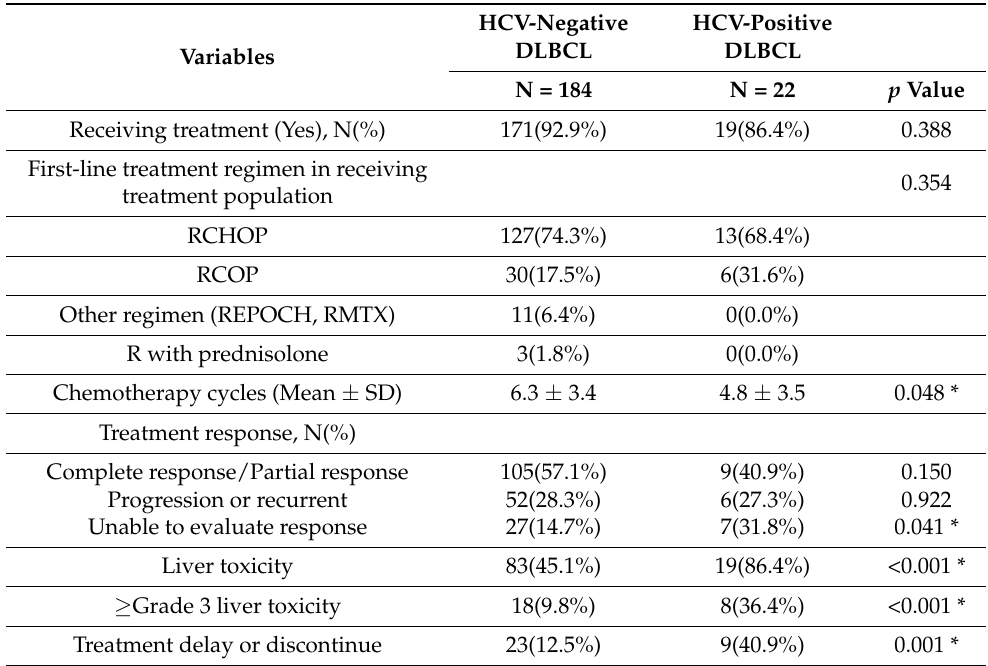
Table 2. Treatment detail, response, and liver toxicity in HCV-negative and HCV-positive DLBCL